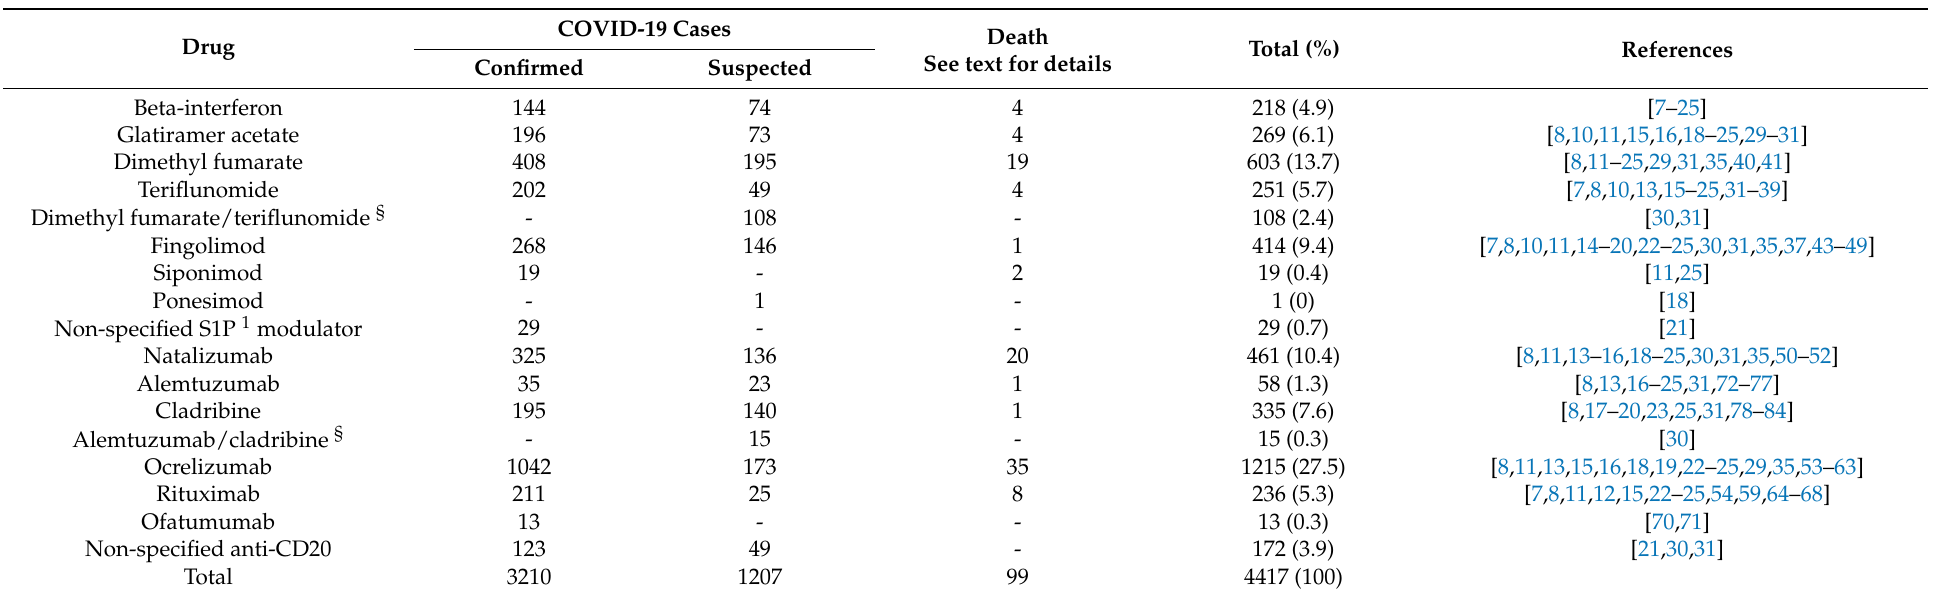
Table 1. Disease modifying therapies in Multiple Sclerosis patients with